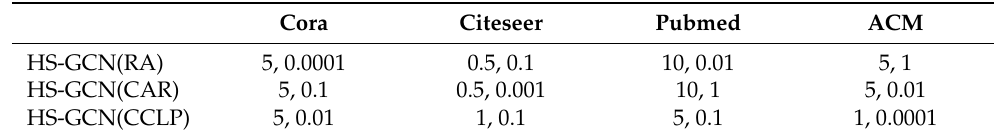
Table 5. The hyperparameters ( λ , α ) for optimal